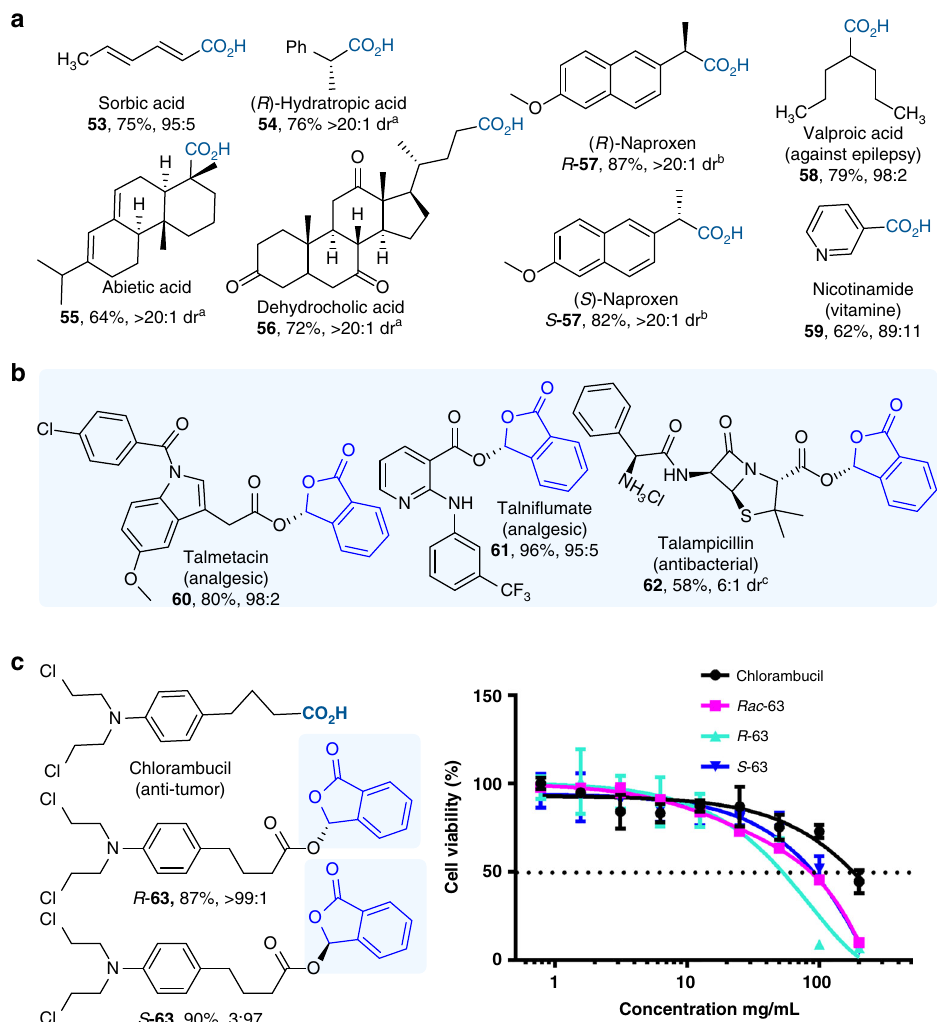
Fig. 5 Natural products and medicinal molecules. a Natural products modi fi ed using our approach. b Marketed prodrugs synthesized via our approach. Reaction condition: acid (0.1 mmol), o -phthalaldehyde (0.15 mmol), 0.1 equiv. NHC C , 1 equiv. quinone, 0.6 equiv. K 2 CO 3 , 0.5 equiv. LiCl, CHCl 3 (2 mL), rt, 12 h. a dr determined by 1 H NMR; b dr determined by HPLC. c with acetone as solvent, yield for 2 steps;. c Bioevaluation of chiral phthalidyl ester prodrugs against the growth of Hela cells ( n = 3 biological replicates, Mean ± SD), Rac- 63 ( R - 63 : S - 63 = 1:1), IC 50 for Chlorambucil: 157.0 mg/mL; Rac- 63 : 83.6 mg/mL; R - 63 : 53.6 mg/mL, S - 63 : 91.7 mg/mL. Source data are provided as a Source Data fi le NATURE COMMUNICATIONS| (2019) 10:1675